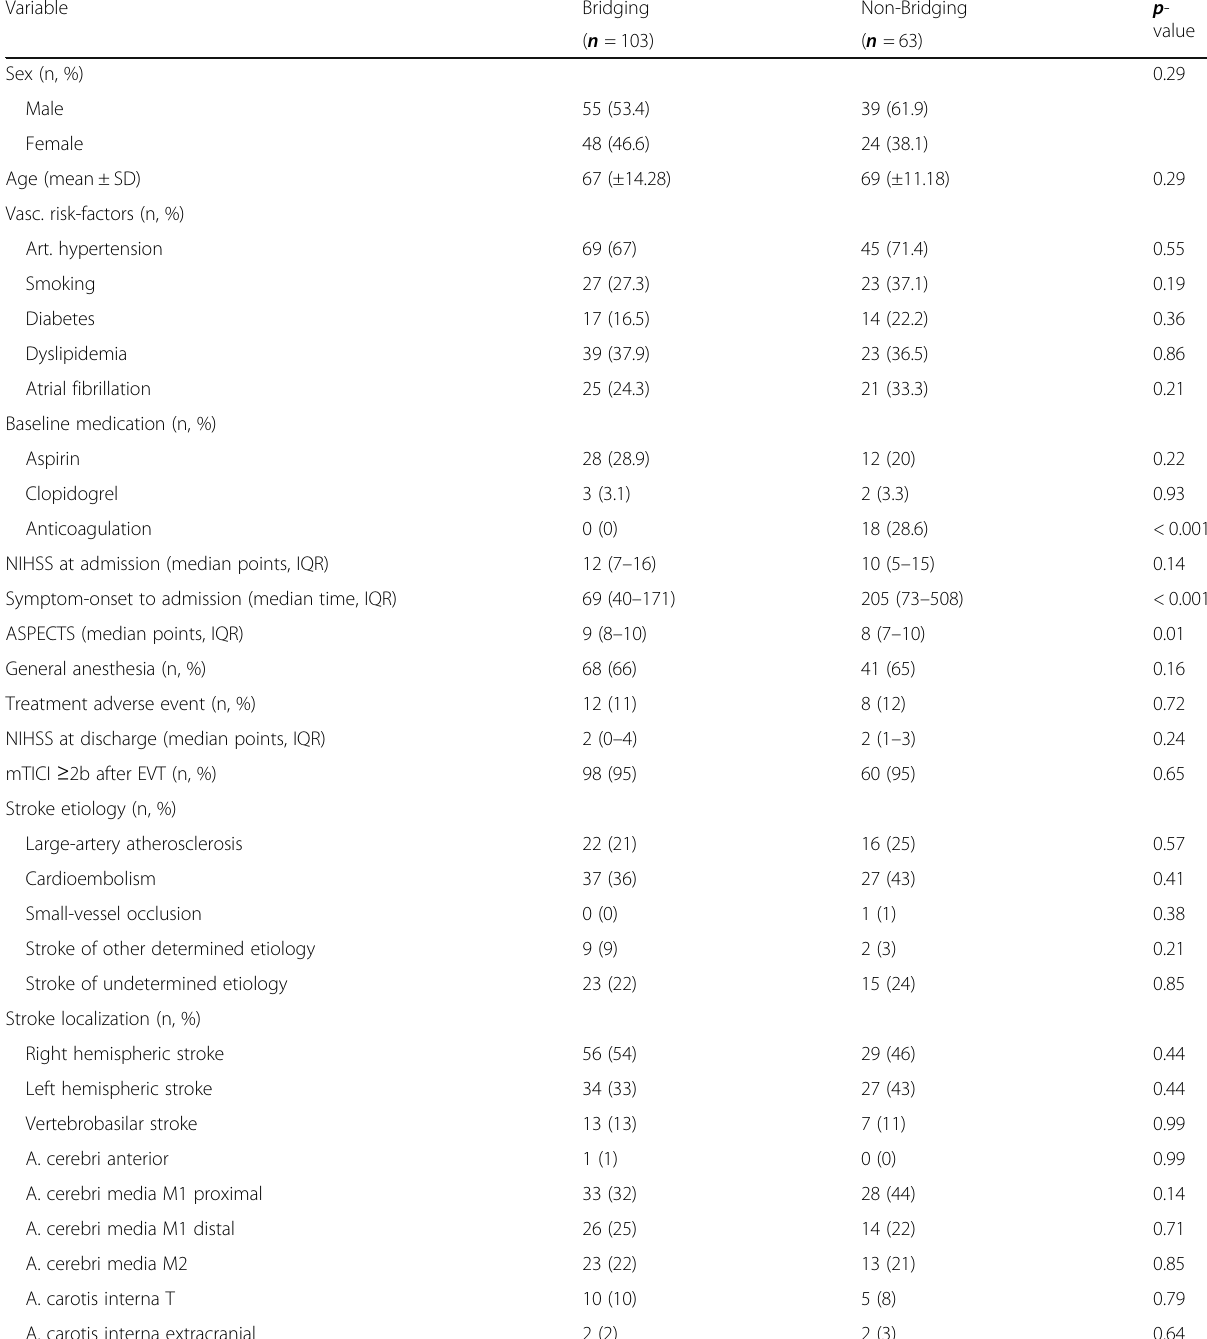
Table 1 Baseline Characteristics MRS ≤